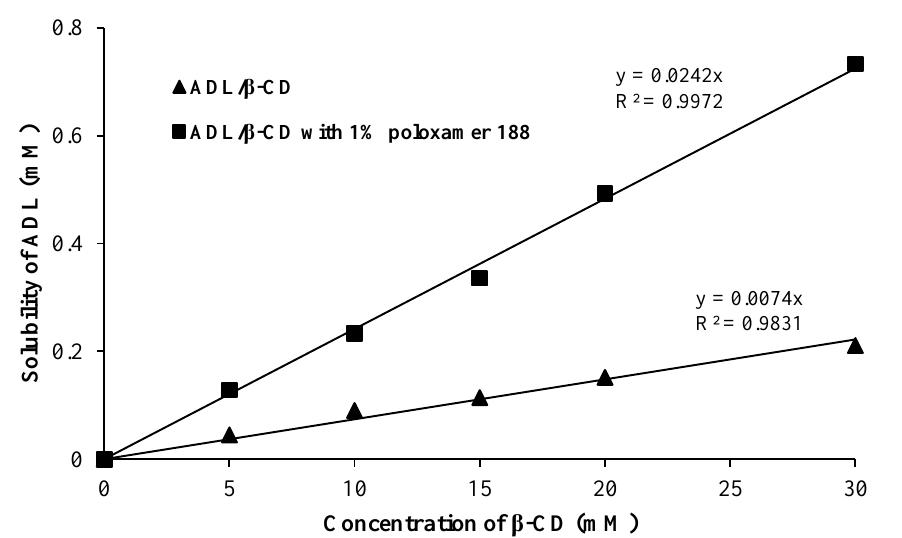
Figure 1. Phase solubility curves of ADL/β-CD and ADL/β-CD with 1% poloxamer 188. Table 1. Complexation parameters of ADL/β-CD and ADL/β-CD with poloxamer 188. Complexes Stability Constant ( Ks ) Complexation Efficiency (CE) Arbidol/β-CD 550 M −1 0.0064 Arbidol/β-CD 2134 M −1 Poloxamer 188